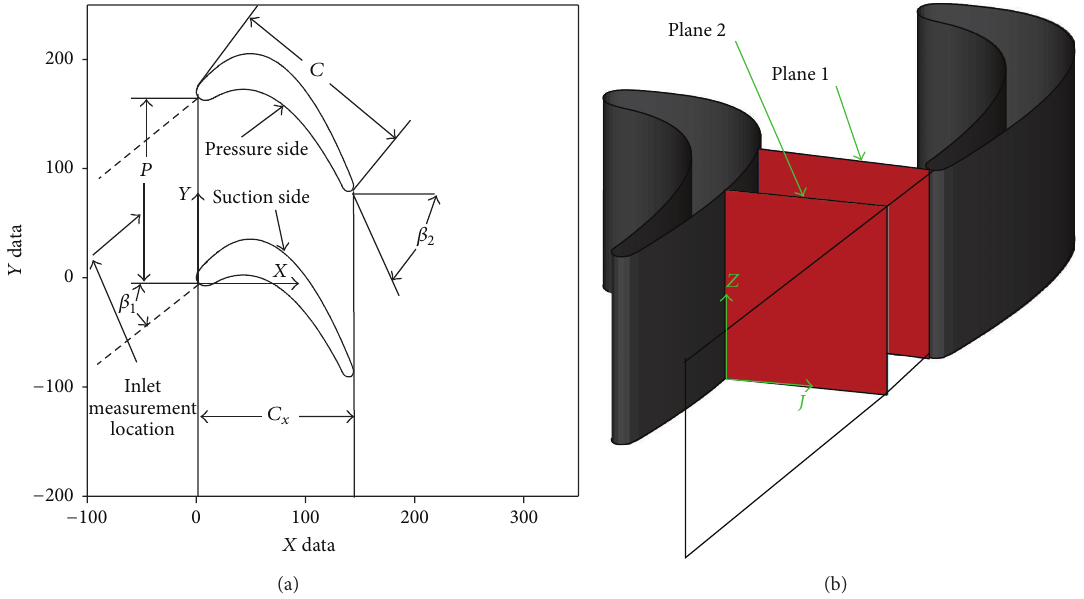
Figure 3: (a) Cascade parameter, coordinate system, and (b) locations of measuring planes.